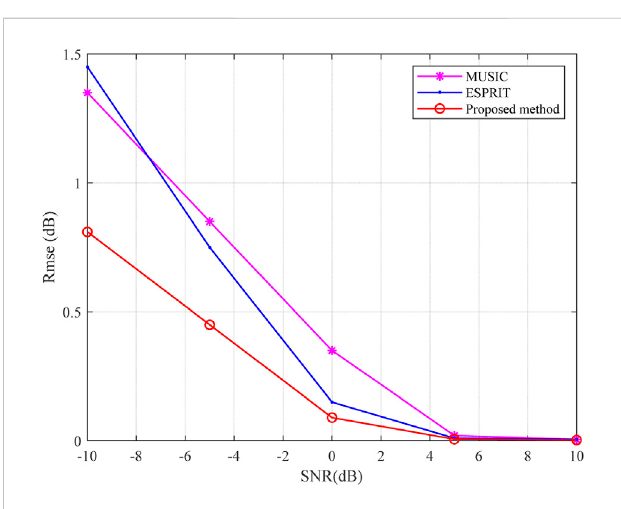
FIGURE 5 DOA estimation performance with different